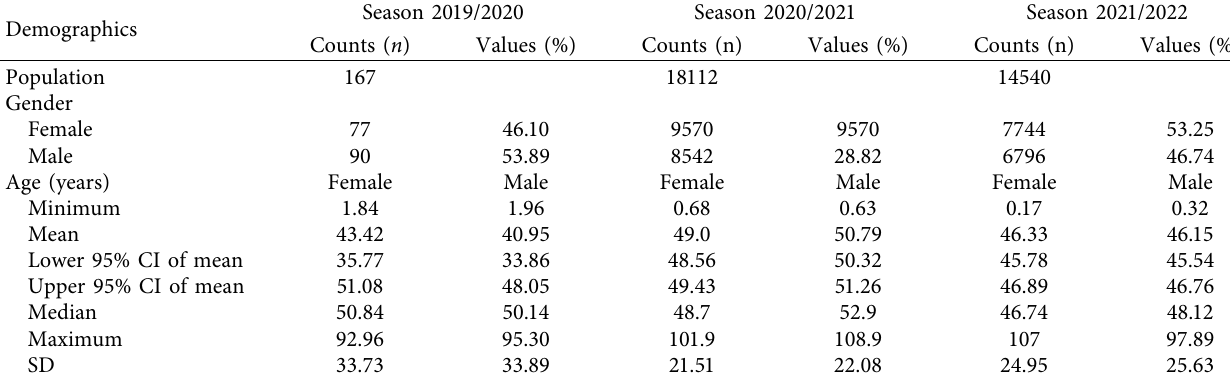
Table 1: Descriptive statistic of study